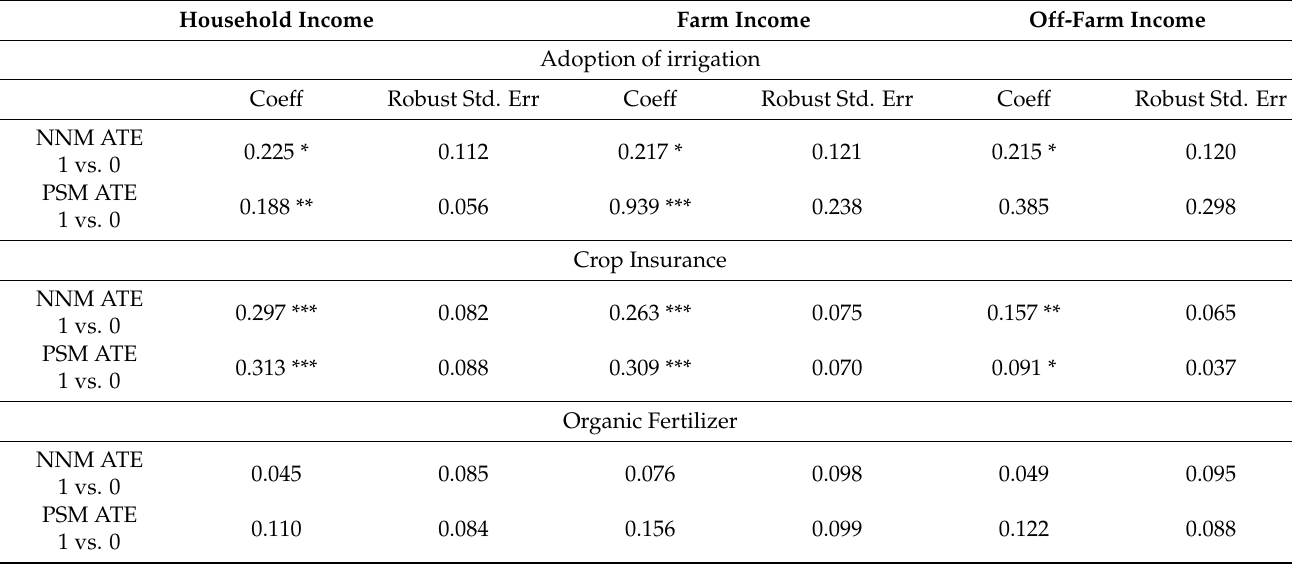
Table 10. Nearest neighbor matching and propensity score matching algorithm average treatment effect (robust